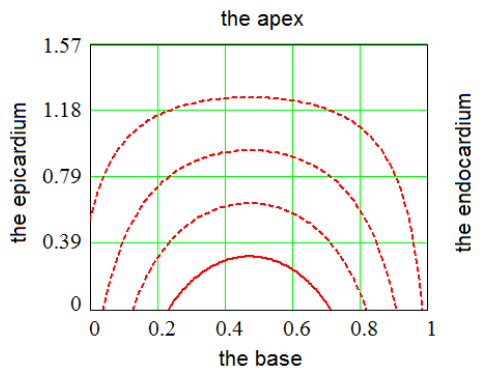
Figure 3. Images of the sector chords in ( γ , ψ ) coordinates. The horizontal axis is γ , and the vertical axis is ψ . Parameter γ 0 = 0.1, and γ 1 =